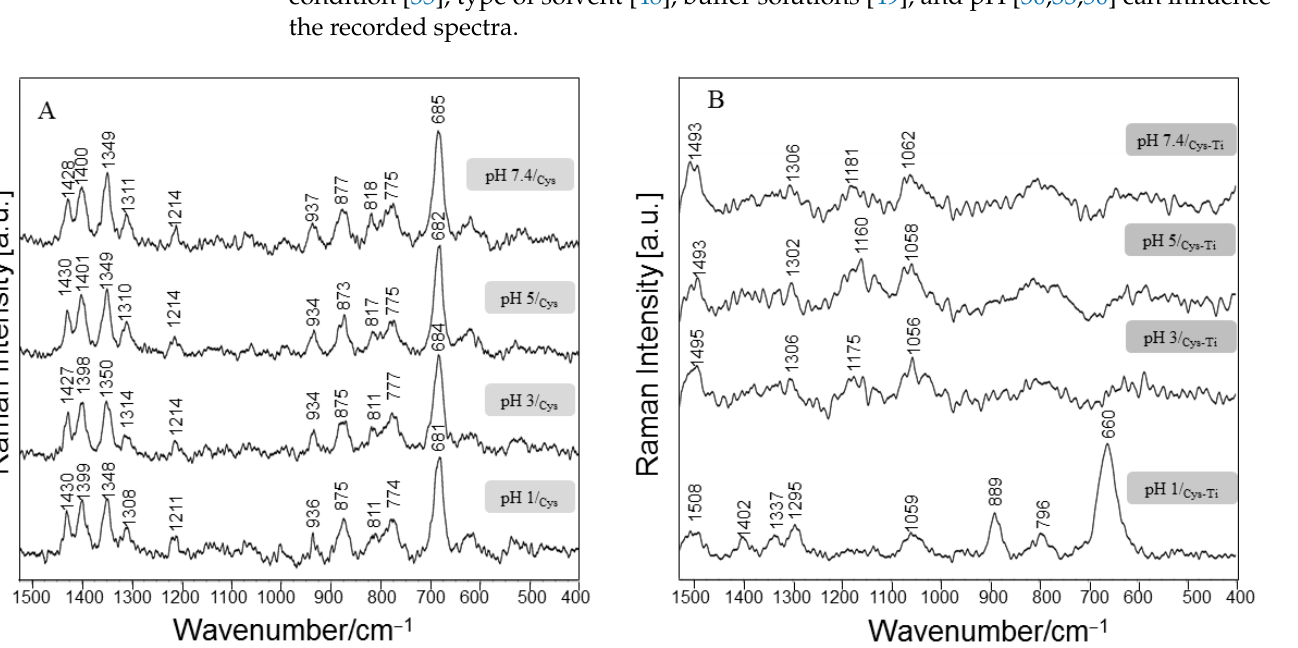
Figure 1. Raman spectra of Cys (10 −1 M/PBS) recorded at different pH in the solution state ( A ) and in situ SERS spectra of Cys (10 −2 M/PBS) recorded at different pH, after 24 h of exposure to the Ti surface in the solution system ( B ).